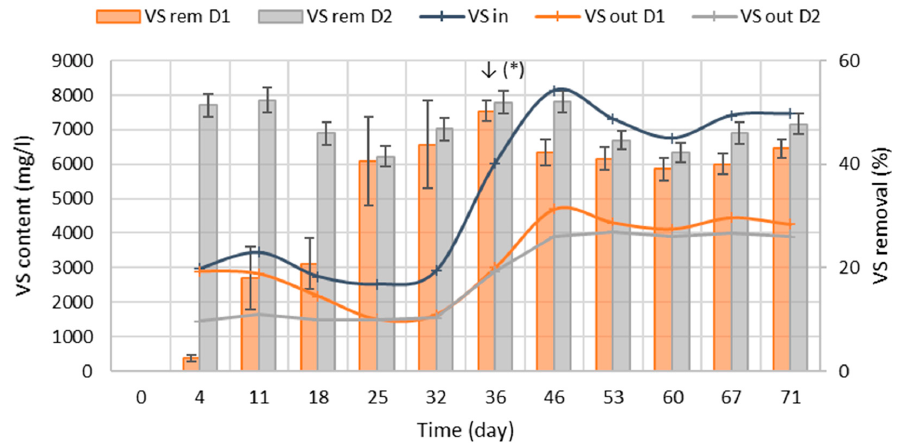
Figure 2. Evolution of VS concentration in the input and in digestates from D1 and D2, and of VS removal rates. ↓ (*) = implementation of influent sedimentation.